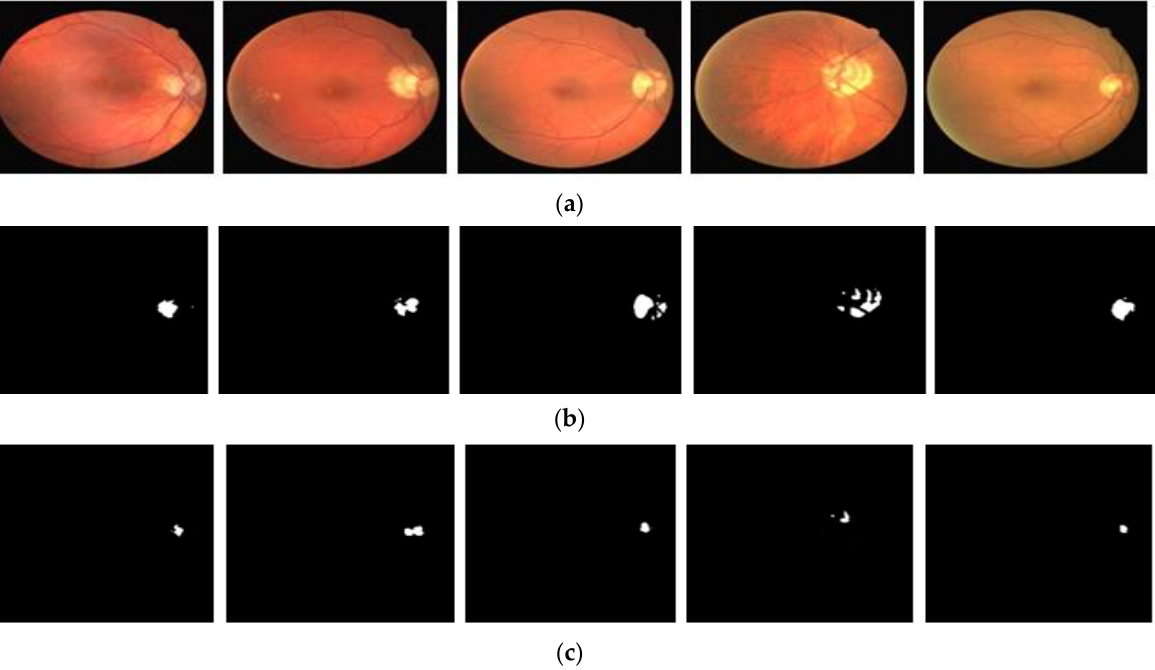
Figure 6. Results: ( a ) original image; ( b ) OD segmented image; ( c ) OC segmented image.